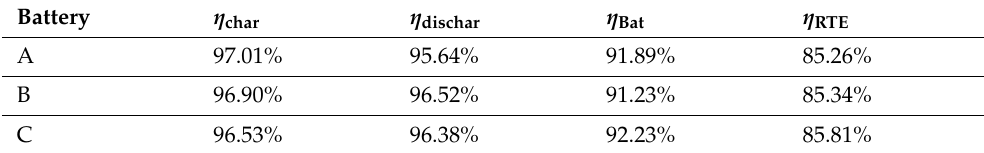
Table 2. Calculated efficiencies.